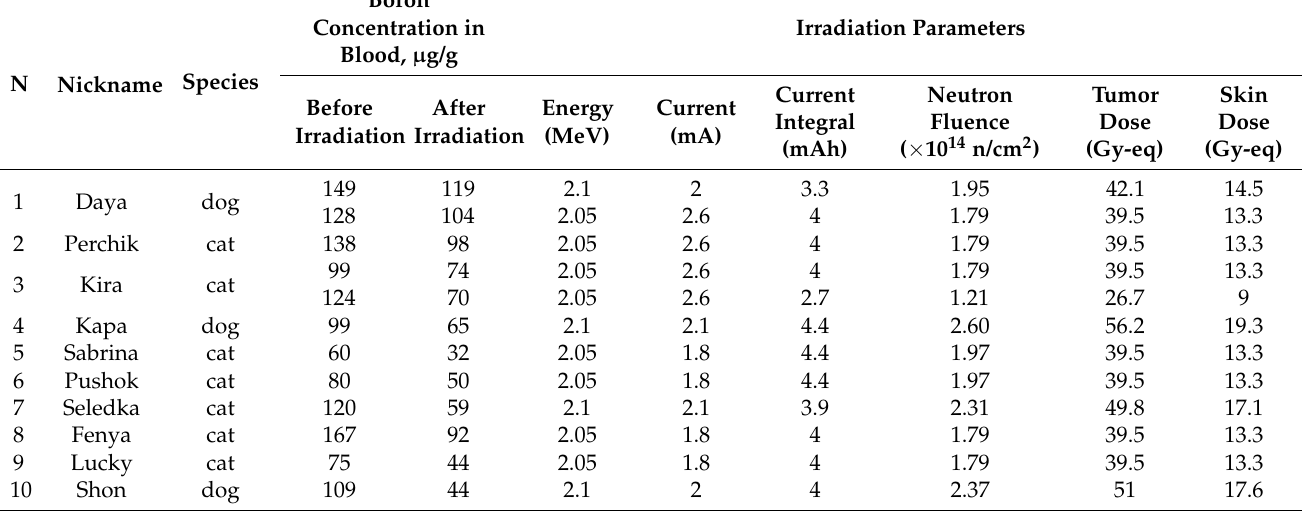
Table 3. Data on the concentration of boron in the blood and parameters of irradiation in animals participating in the